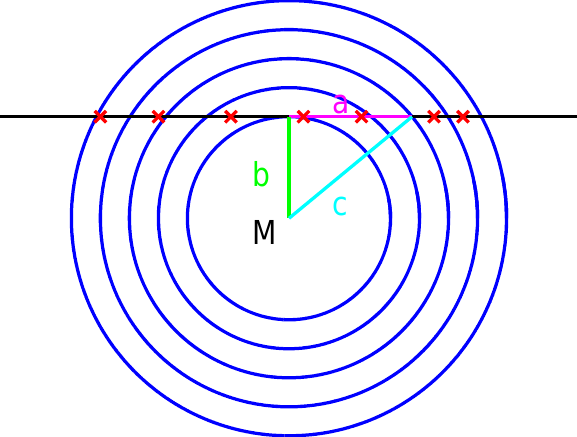
Fig. 14. Path lengths in different grid cells for a typical line-of- sight (LOS) of a limb measurement. The biggest part of the path lies in the tangent point altitude region, but higher altitudes are also passed. Note that for the contribution of a grid element’s emission to the total emission along the LOS, the path length in the grid interval as well as the density of the emitters in the grid interval and the absorption of the emitted light along the LOS have to be considered. For measurements with tangent altitudes far below the metal layer peak, where the density is far smaller than in the peak region, the emission signal mainly comes from the region above the tangent altitude.